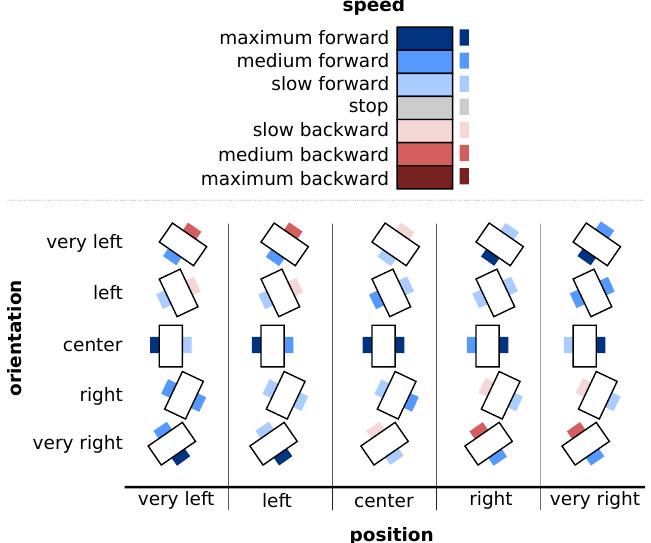
Figure 11. Rule chart. The detailed rules for the left and right wheel speeds according to the position and orientation of the